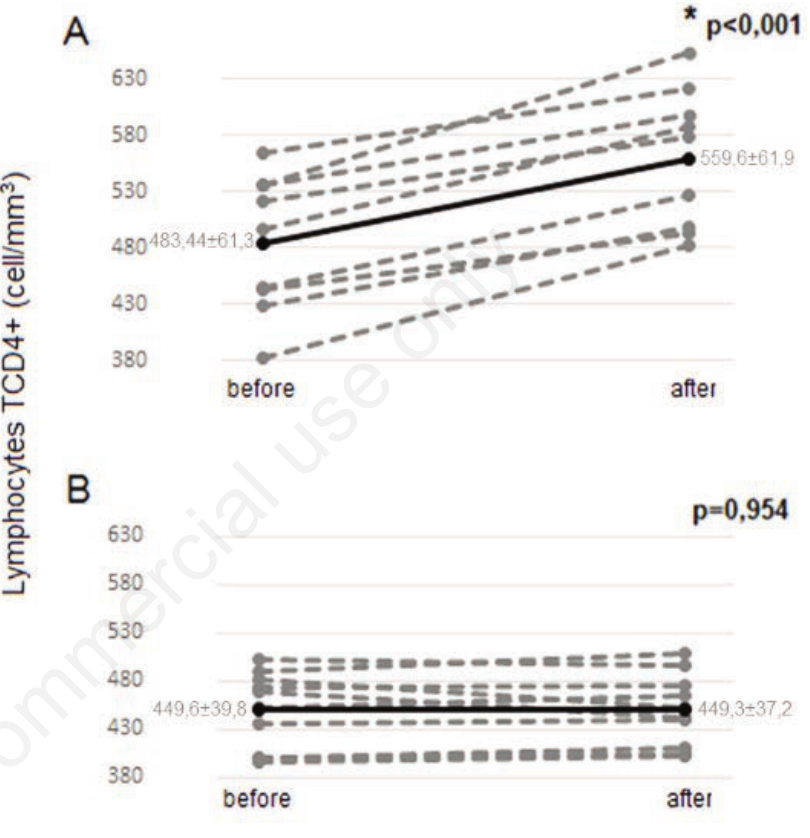
Figure 2. Variation of the CD4 + T lymphocytes counting of patients living with HIV/AIDS before and after submission to the training period (A) and the group that did not undergo the intervention (B). Full lines indicate the mean variation of all patients evaluated; dotted lines indicate the individual data of each study participant. P-value cal- culated by the Paired T test for related